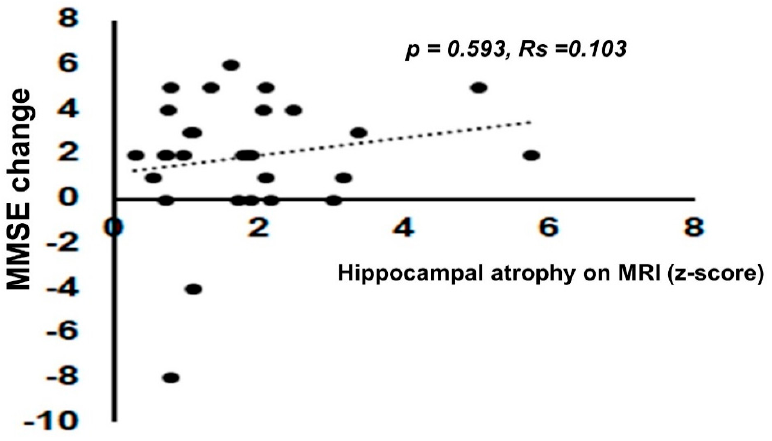
Figure 6. The degree of improvement in cognitive function by folate supplementation and hippocampal atrophy level were not significantly correlated. The degree of improvement of the MMSE score by folate supplementation and hippocampal atrophy as estimated by z-score by the voxel-based specific regional analysis system developed for the study of Alzheimer’s disease (VSRAD) ( p = 0.593, Rs = 0.103). Spearman’s rank correlation coefficient was used for analysis because the data deviated from a normal distribution.